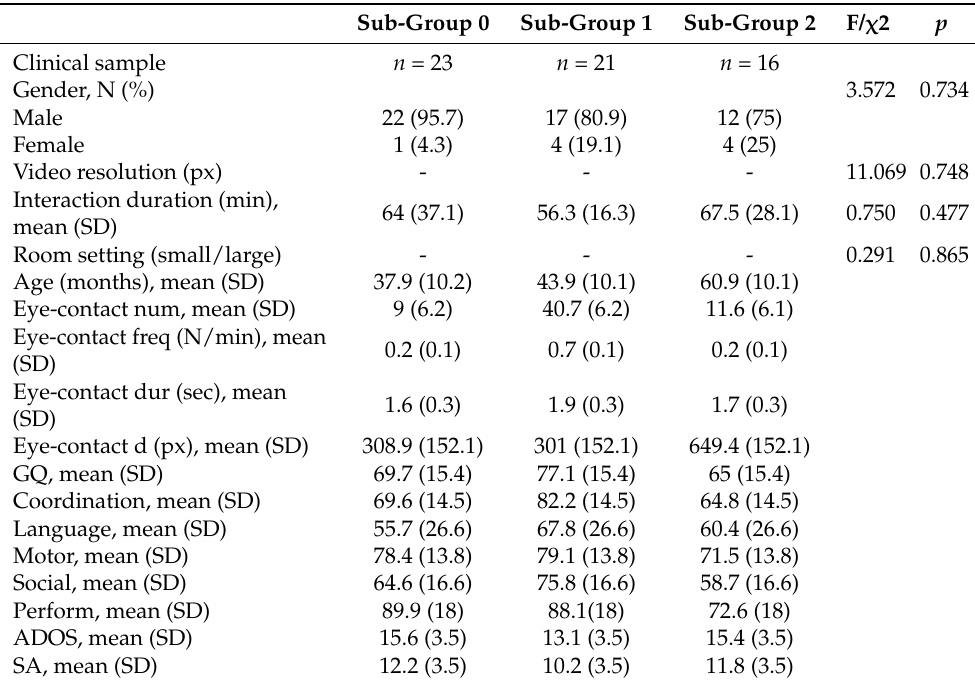
Table 5. Sub-groups